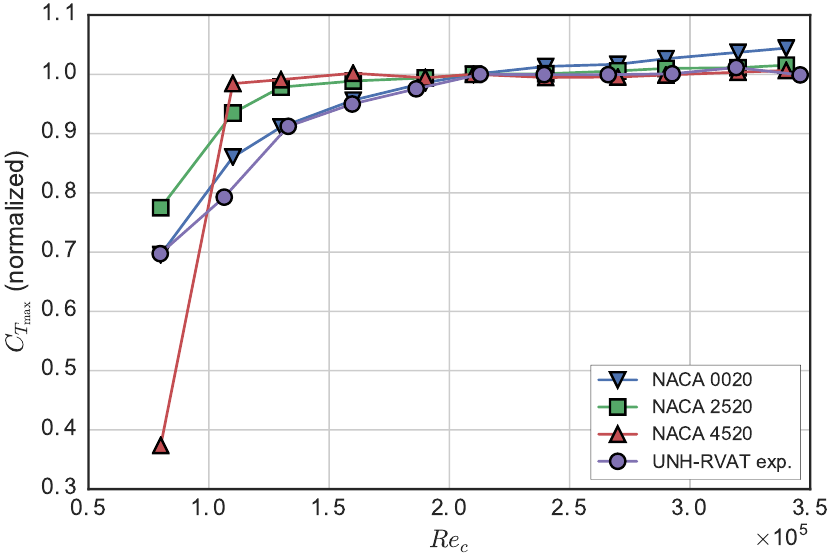
Figure 9. Reynolds number dependence of the normalized peak torque coefficient calculated from static foil coefficients and blade kinematics, compared to experimental data from a cross-flow turbine. Note that the experimental data represents the mean torque coefficient, not the